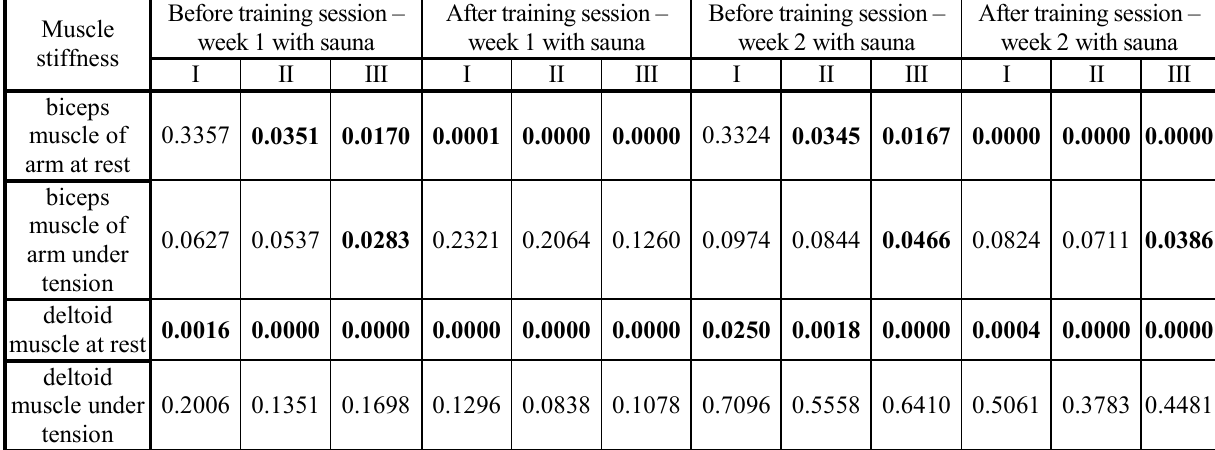
Stiffness parameters for Wroclaw “START” Sports Club-based swimmers in the training cycle with athletic